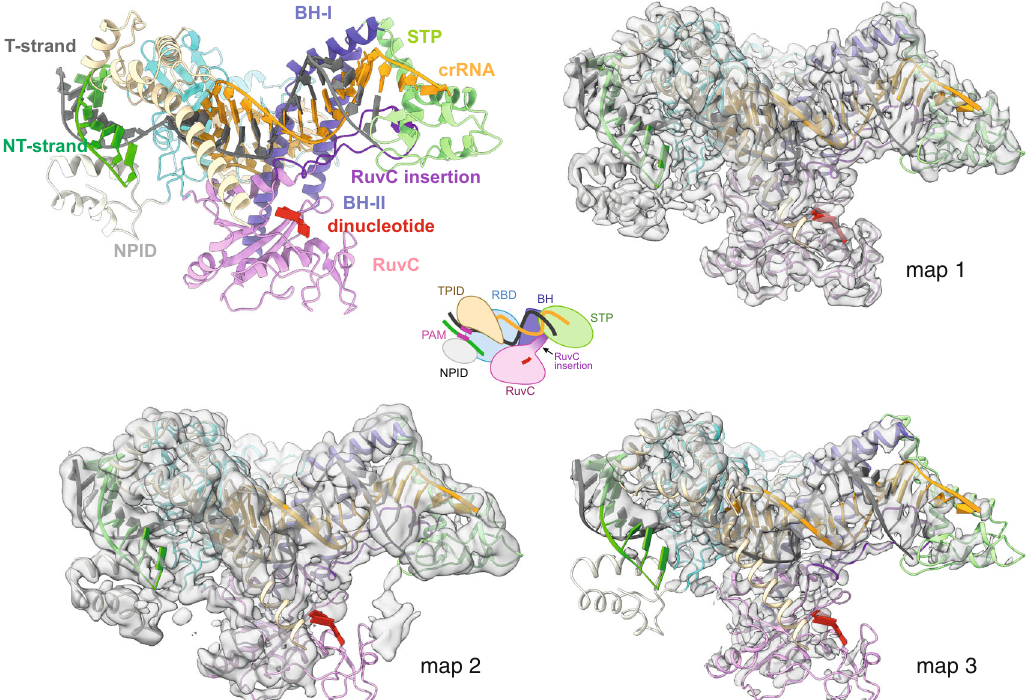
Fig. 3 Cas12j3/R-loop atomic model and cryo-EM maps. Comparison of the three cryo-EM maps (Supplementary Fig. 3d, Supplementary Fig. 4 and Supplementary Table 1). The top left ribbon diagram and the central cartoon are included to facilitate the comparison between the maps. The maps indicate the high fl exibility of the NPID, RuvC and STP domains and extra density from the T-strand in map2 (Supplementary Movie